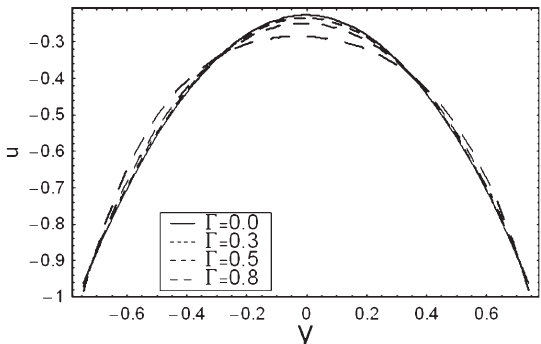
Fig. 13. Effect of the Deborah number (cid:15) on the variation of longitu- dinal velocity u plotted for a = 0 . 3, b = 0 . 6, d = 0 . 9, Re = 1 . 5, φ = π/ 4, Fr = 1 . 1, α = π/ 6, θ = 1 . 2, x = − π/ 3, β = 0 . 02 and dp (2) /dx =